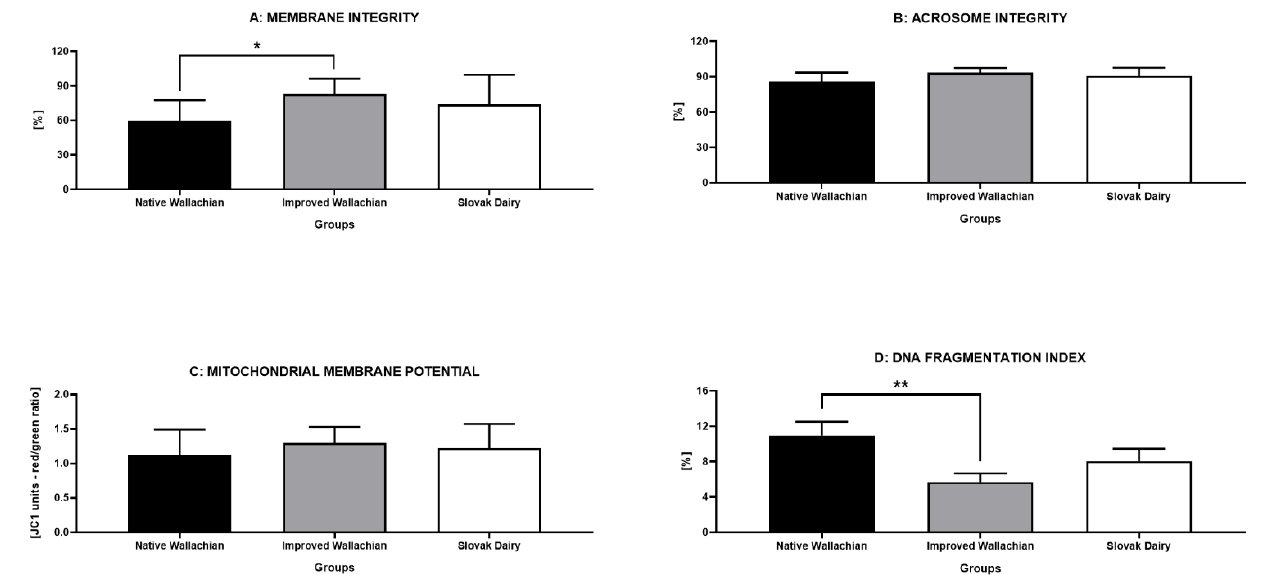
Figure 5. Comparative analysis of the sperm structural integrity parameters among the pre-estab- lished groups of ram semen samples. * p < 0.05; ** p < 0.01.